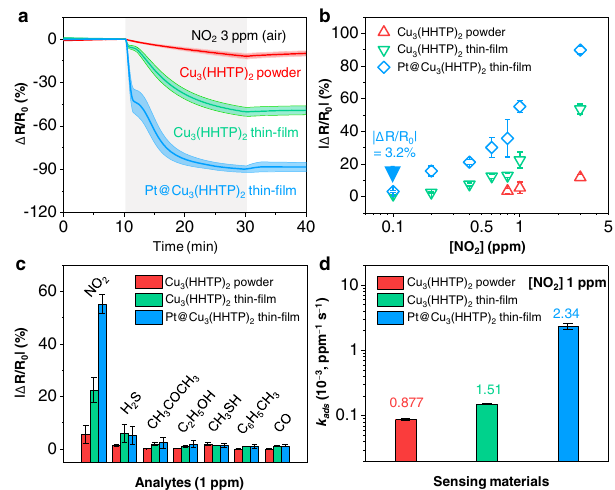
Fig. 4 Sensing characteristics of Pt@Cu 3 (HHTP) 2 thin fi lm (shearing speed: 2 mm/s) on alumina (Al 2 O 3 ) substrate at 150°C. a Resistance changes of Cu 3 (HHTP) 2 powder, Cu 3 (HHTP) 2 thin fi lm, and Pt@Cu 3 (HHTP) 2 thin fi lm in response to 20 min exposure of NO 2 3 ppm. The shaded areas present the standard deviation of the sensors ( N ≥ 4). b Normalized responses of the sensors to 0.1 – 3 ppm of NO 2 . c Selectivity of the sensors to 1 ppm of analytes. d Calculated adsorption rate constants ( k ads ) of the sensors. @ means – embedded. The error bars in b – d show the standard deviation of the sensors ( N ≥